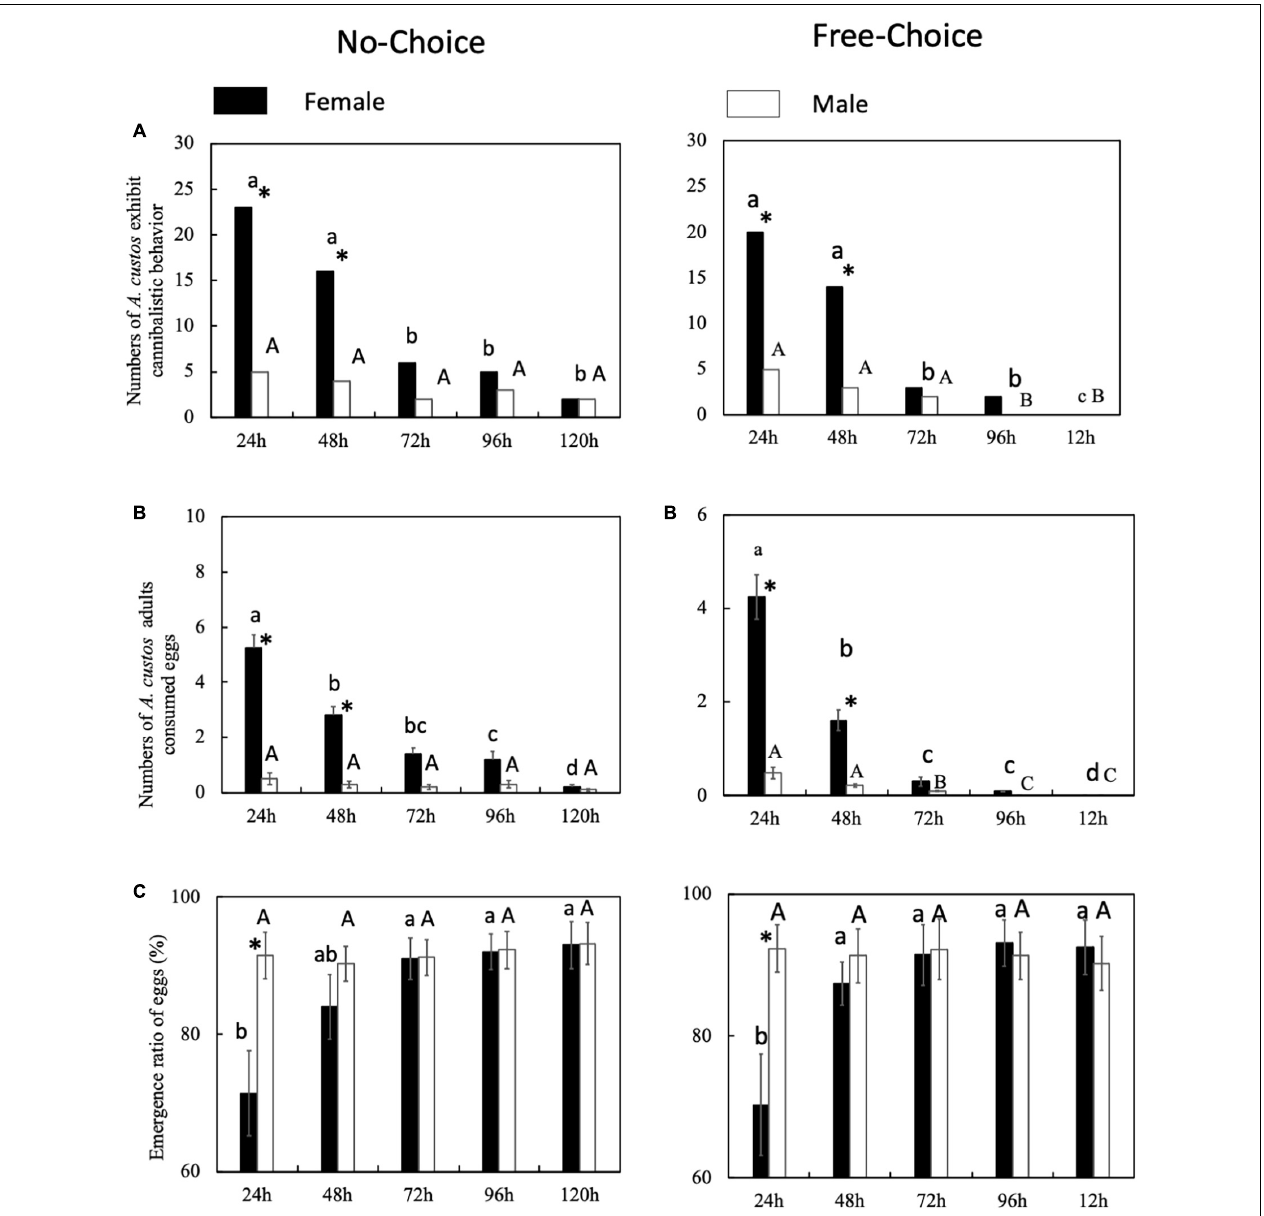
FIGURE 2 | (A–C) Predatory behavior by A. custos with different aged eggs under no choice and free choice conditions. Different lowercase letters indicate significant differences among females at P < 0.05 and different uppercase letters indicate significant differences among males at p < 0.05. The investigation was repeated 30 times. * indicates a significant difference between the black bar (females) and white bar (males) at P < 0.05.